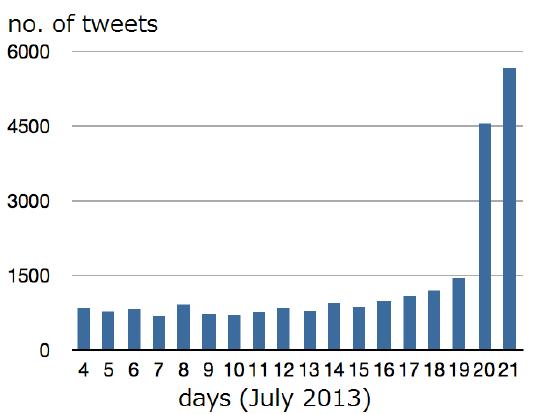
Figure 8. Tweets which appeared in each day till the day of election. The outline of the system is represented in Figure 9.